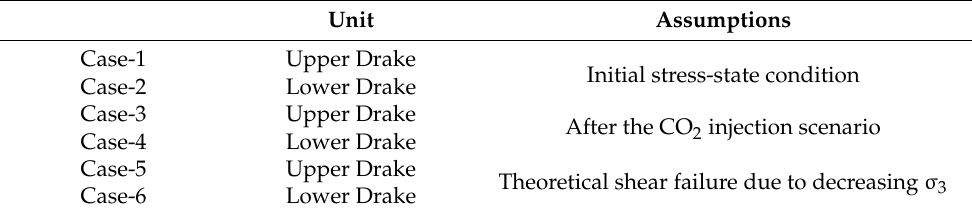
Table 1. Different model scenarios were tested in this study to evaluate Drake caprock shale’s